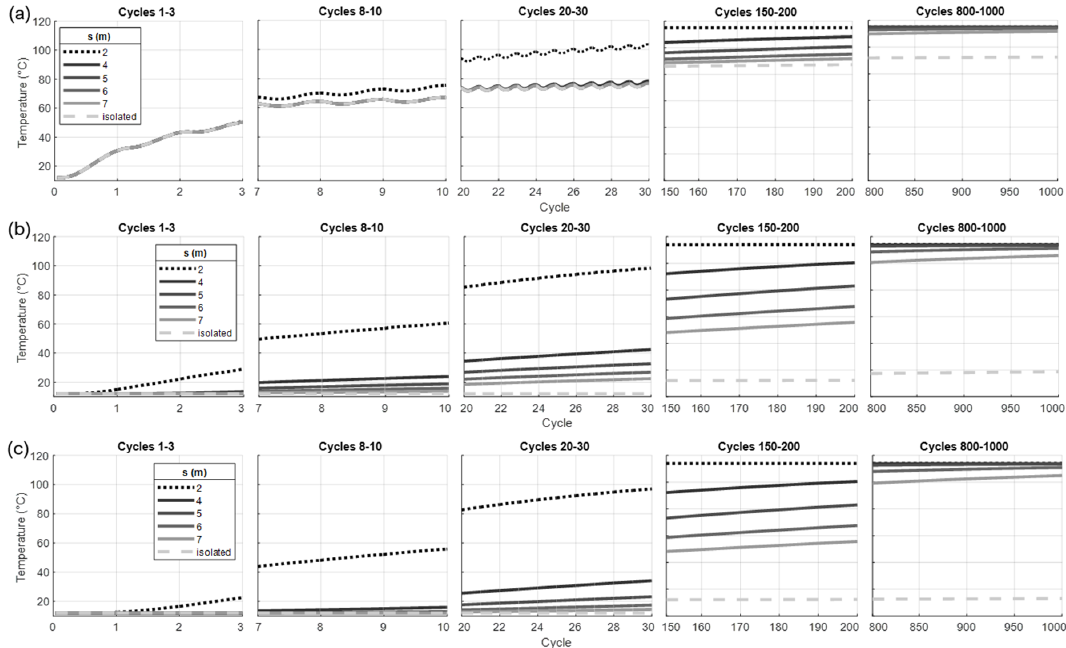
Figure 12. Temperature history within multiple cycles (1st–3rd, 8–10th, 20–30th, 150–200th, and 800–1000th) for θ = 0 ◦ at ( a ) the inner surface of the soil; ( b ) the quarter of the soil layer; ( c ) and the center between two